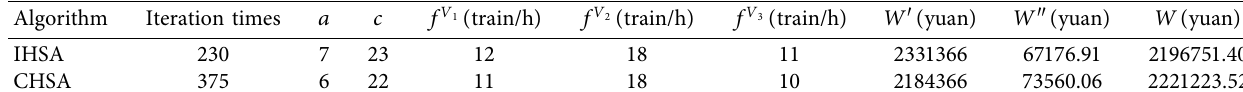
Table 10: Comparative analysis of IHSA and CHSA (the third set of